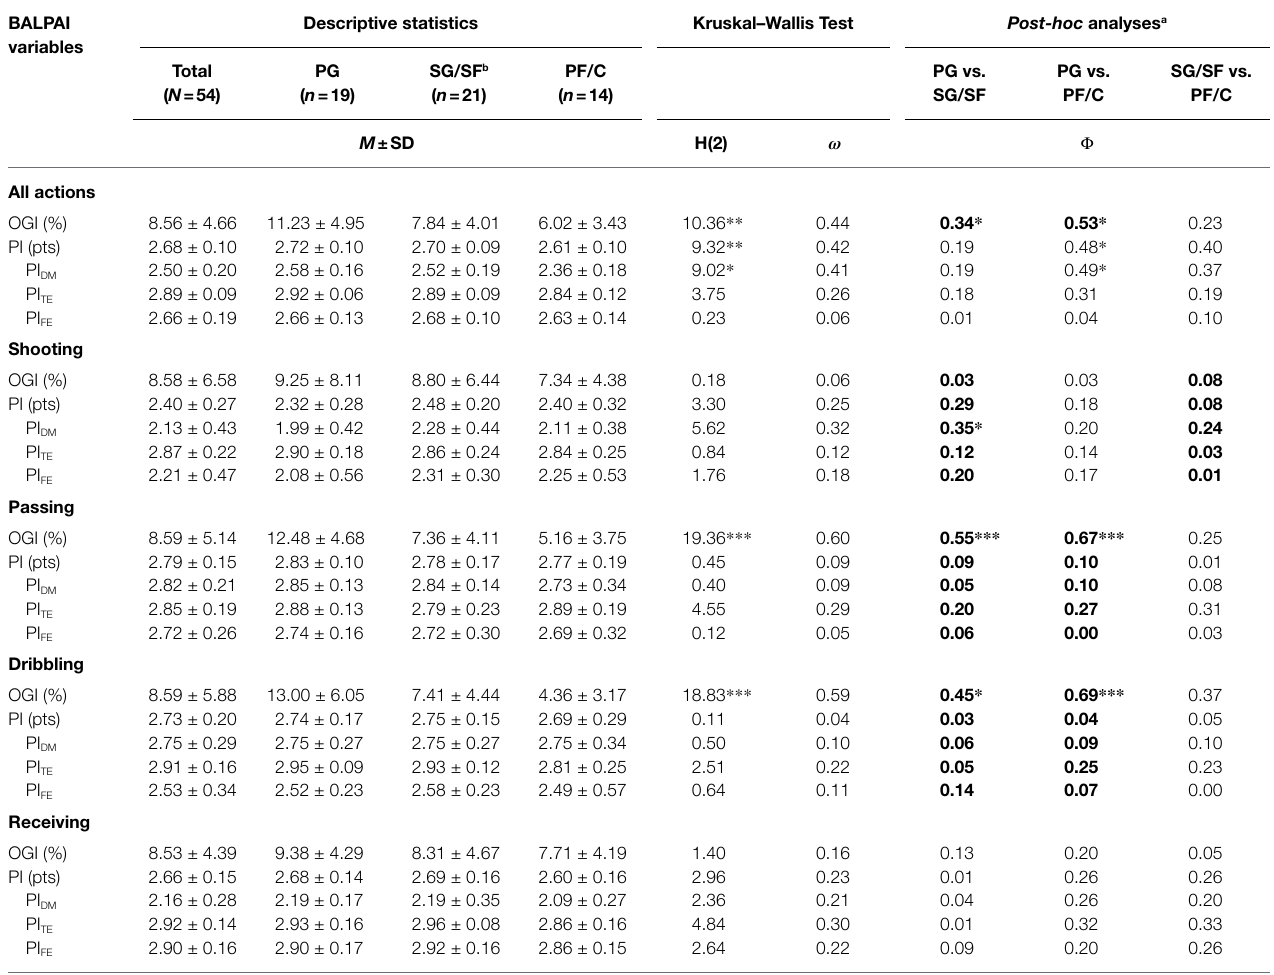
TABLE 3 | Descriptive statistics and multiple group comparisons for BALPAI variables separated by playing position. BALPAI